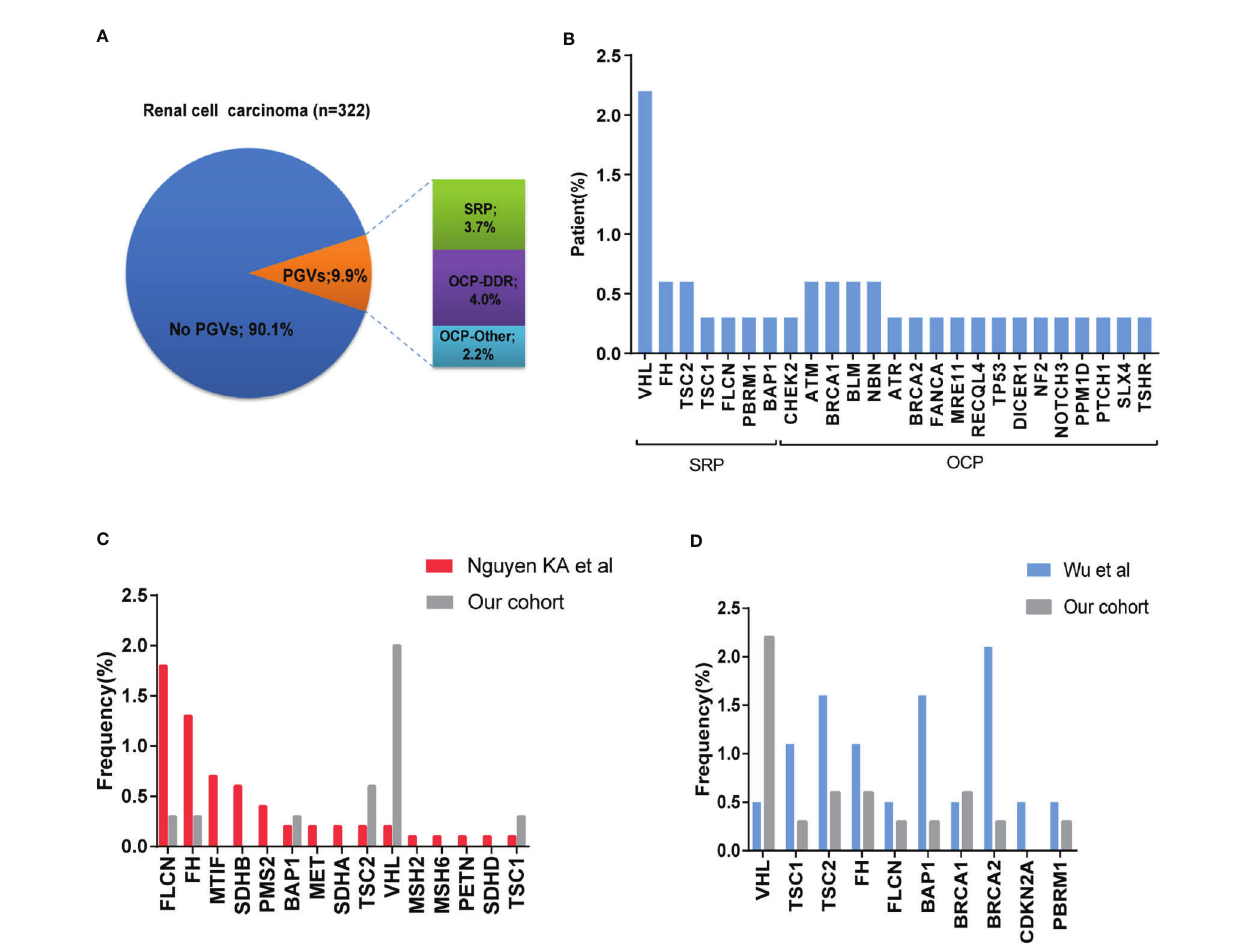
FIGURE 2 | Frequency and spectrum of pathogenic germline mutations in patients with RCC. (A) Frequency of germline variants in patients with RCC. Frequency of pathogenic/likely pathogenic (P/LP) germline variants (PGVs) identi fi ed in 322 patients with RCC. Pie chart shows that 9.9% (32/322) of patients were identi fi ed to have PGVs with 3.7% (n =13) having PGVs in syndromic RCC-associated genes, and 6.3% (n = 19) carrying PGVs in other cancer-associated genes. (B) Frequency by gene of PGVs detected in this study. (C, D) Comparison of frequency of germline pathogenic/likely pathogenic mutation in our study with that from Nguyen cohort and Wu